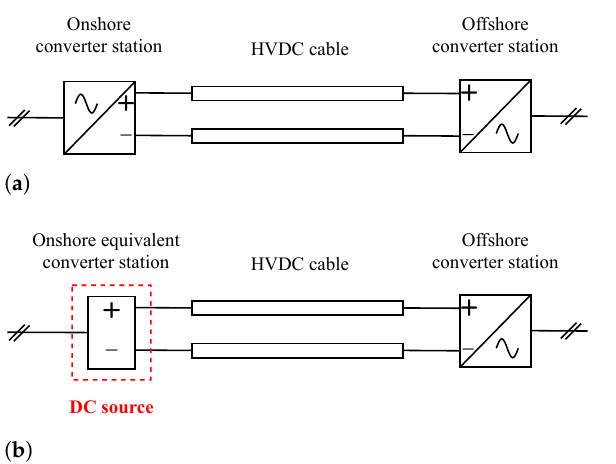
Figure 6. Symmetrical monopole configuration in HVDC network. ( a ) Symmetrical monopole configuration; ( b ) Symmetrical monopole configuration by equivalent representation of DC side of onshore MMC station using a constant DC